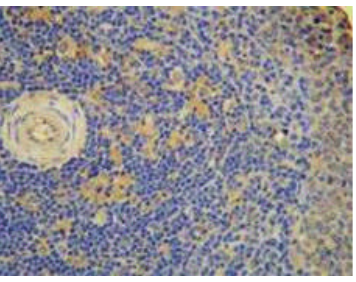
Figure 8: Model control group—21d in OJ experiment (++) spleen, Bax × 200.